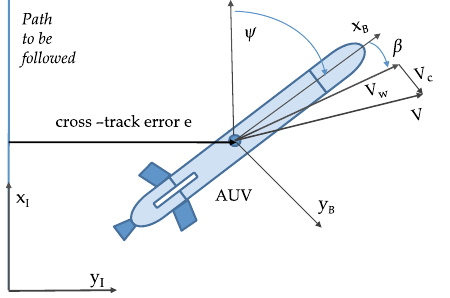
Figure 5. Marine vehicle body reference frame showing the cross-track